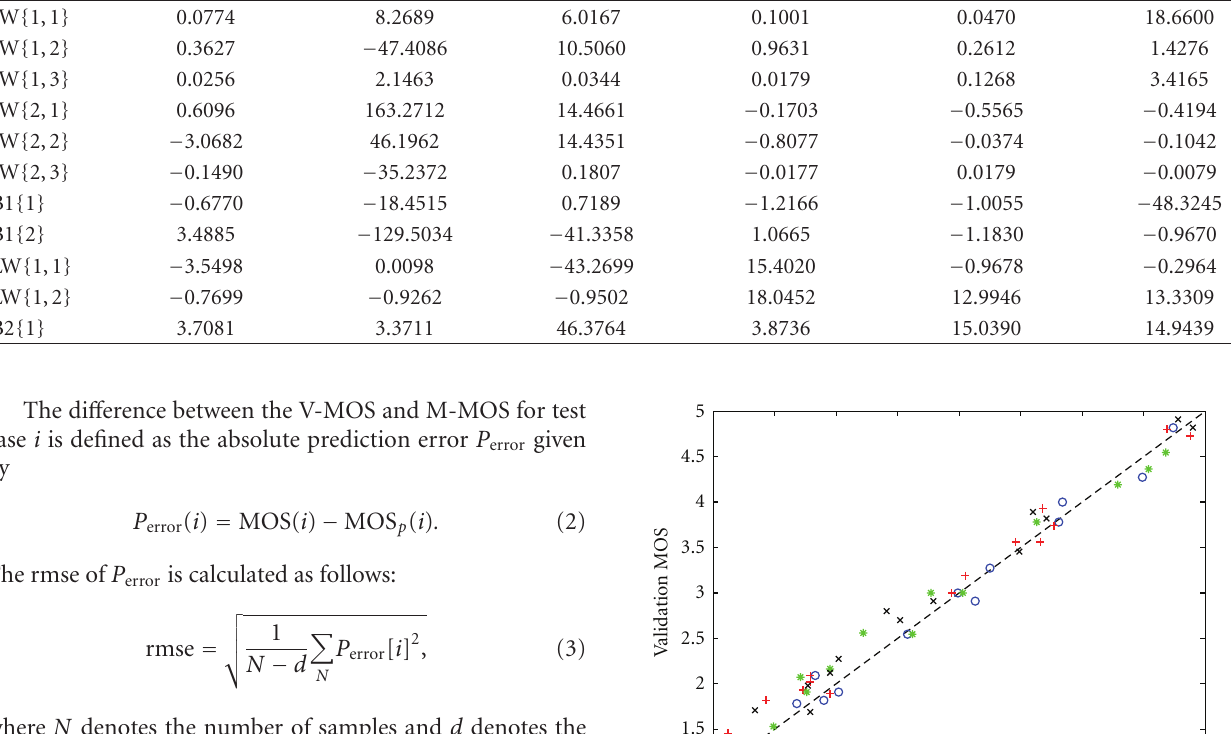
Table 9: PFIFO model parameters showing weights and biases for SD and HD resolutions. Params.